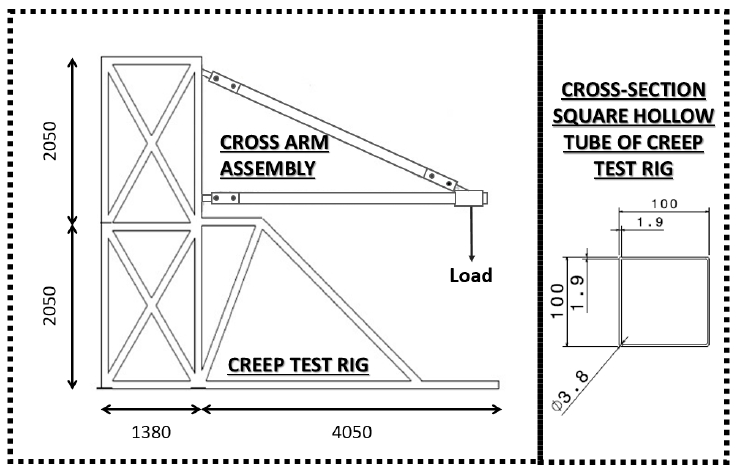
Table 1. Specification of material of creep test rig [19].